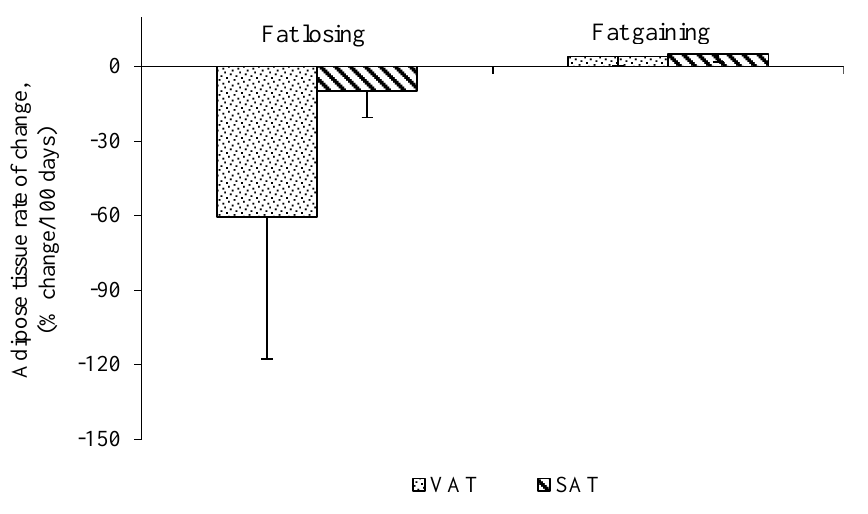
Figure 1. Mean rate of visceral adipose tissue (VAT) and subcutaneous adipose tissue (SAT) change in fat losing cancer patients assessed by consecutive computed tomography (CT) scans. Data are represented as Mean ± SD, n = 5 (Fat Losing) and n = 2 (Fat Stable), p < 0.05 VAT, visceral adipose tissue; SAT, subcutaneous adipose